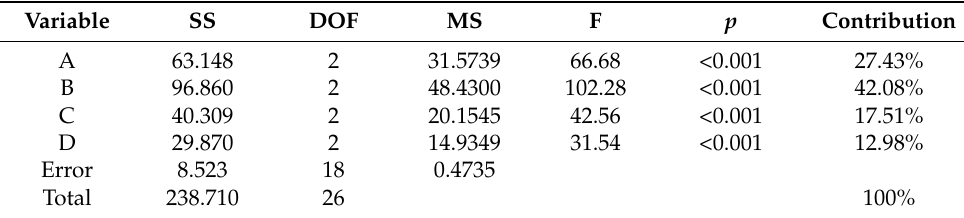
Table 8. ANOVA result for the tensile strength.